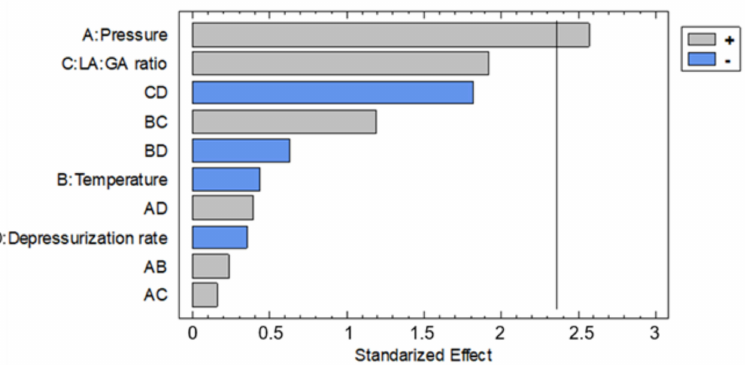
Figure 6. Effect of the considered variables on the rutin loads impregnated onto the foamed poly- mer samples.